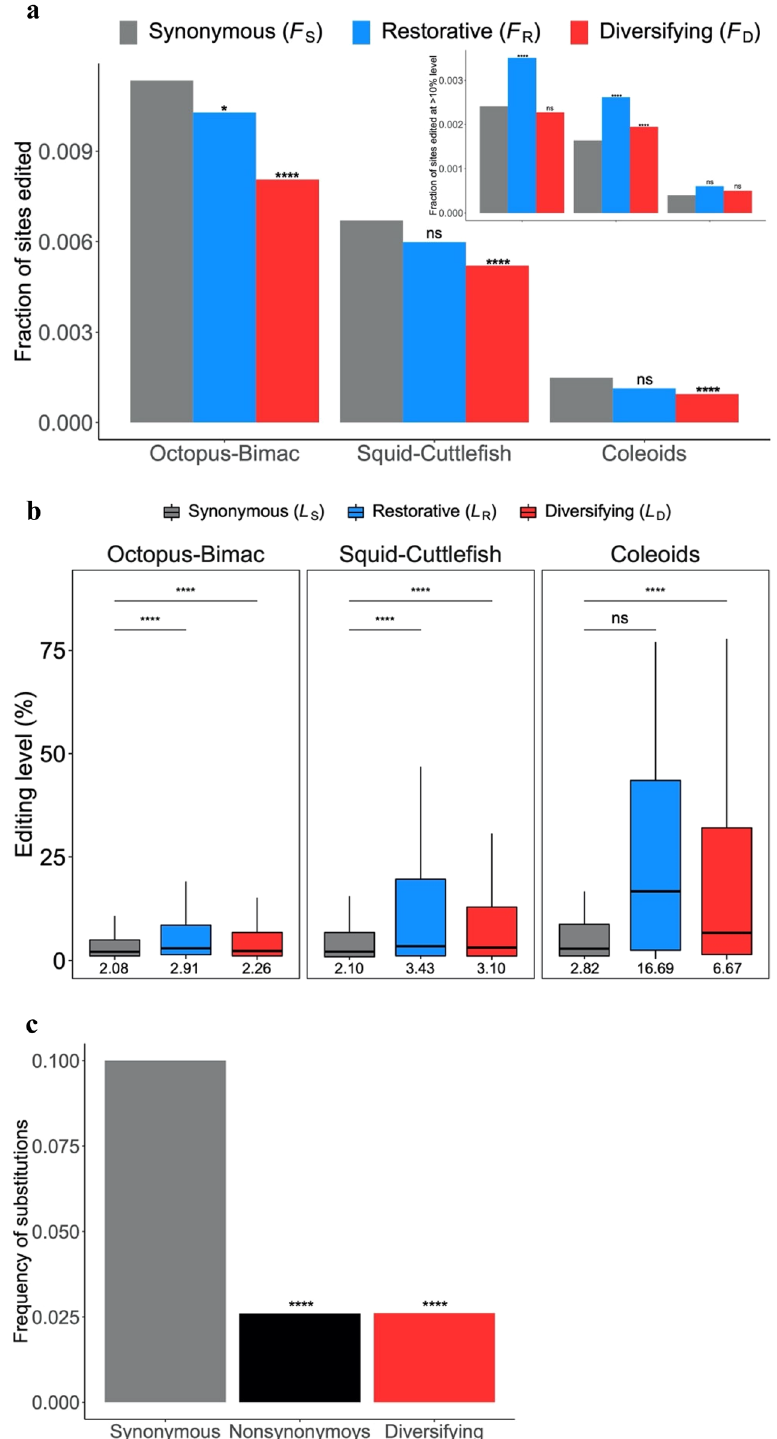
Fig. 4 Patterns of shared editing in coleoids. a Frequencies of sites with shared synonymous ( F S ), restorative ( F R ), and diversifying ( F D ) editing, respectively, among sites shared between the octopus and bimac, between the squid and cuttle fi sh, and among all four coleoids, respectively. A signi fi cant difference between F S and F R (or F D ) is indicated by stars above the bin of F R (or F D ) (* P < 0.05; ** P < 0.01; *** P < 0.001; **** P < 0.0001; ns, not signi fi cant; χ 2 -test).The inset shows the corresponding fractions of sites with editing levels >10%. b Synonymous ( L levels among the three sets of shared editing sites. The lower and upper edges of a box represent the fi rst (qu 1 ) and third quartiles (qu 3 ), respectively, the horizontal line inside the box indicates the median (md), and the whiskers extend to the most extreme values inside inner fences, md ± 1.5(qu 3 − qu 1 ). The median editing levels are also given below the corresponding boxes. A signi fi cant difference between L S and L R (or L D ) is indicated by stars (* P < 0.05; ** P < 0.01; *** P < 0.001; * * ** P < 0.0001; ns, not signi fi cant; Mann – Whitney U -test). c Fraction of sites edited in the common ancestor of the four coleoids that have a genomic G in a coleoid. (****, P < 0.0001; chi-squared test). Source data are provided as a Source Data fi